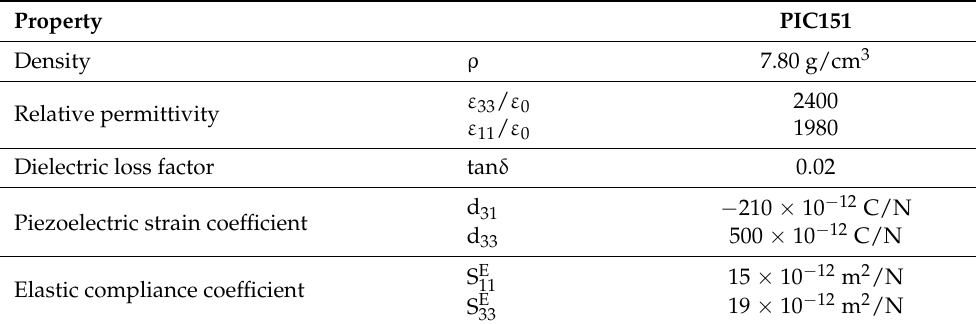
Table 1. Properties of grade PIC151 PZT